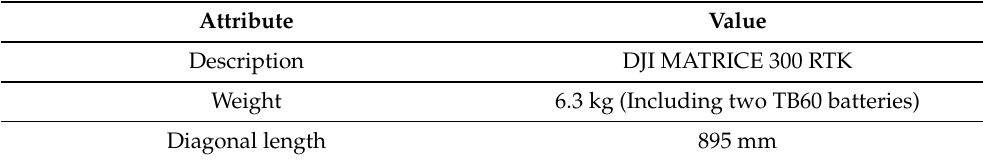
Table 2. UAV specification.